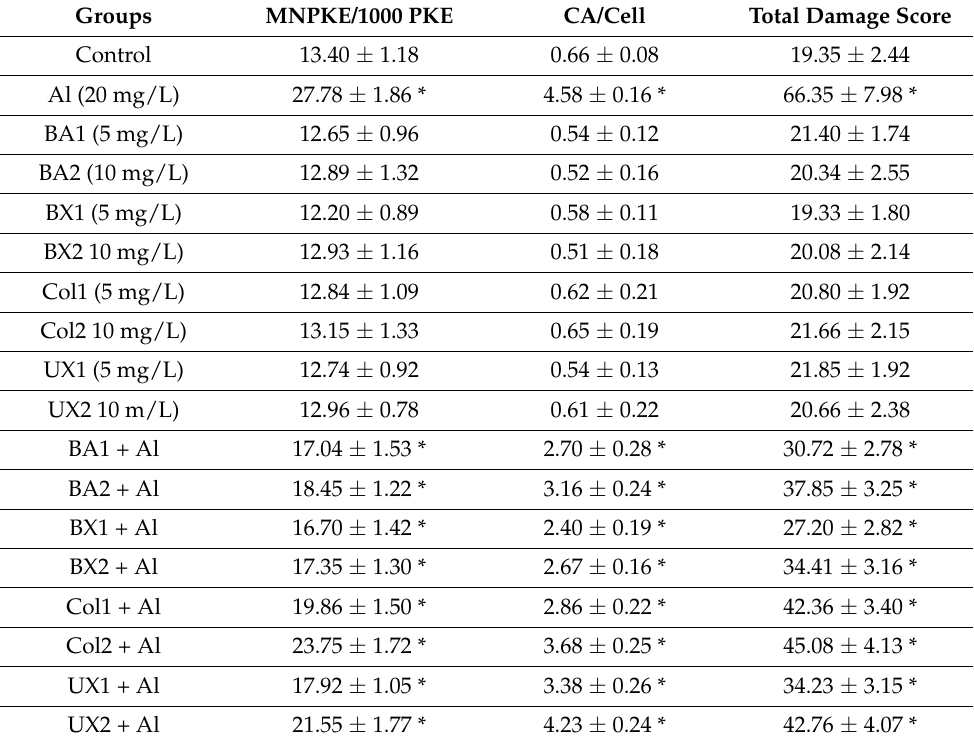
Table 4. The genotoxicity of boron compounds and Al on the CA, MN, SCGE and NDI rates in rat bone marrow